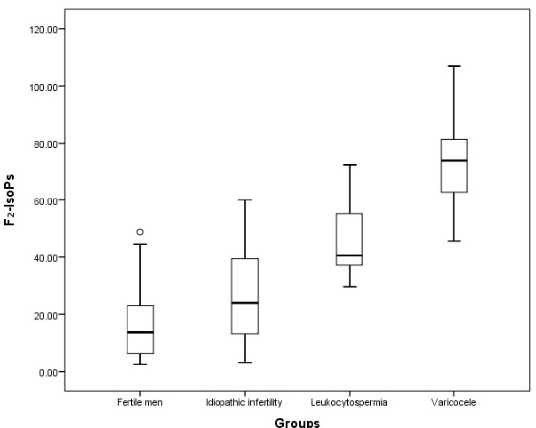
Figure 3. F 2 -IsoP levels in the four examined groups. Values are expressed as median and interquartile ranges (IQR). The symbol on top is an outlier. The seminal RvD1 levels were significantly increased in patients with leukocytosper- mia (respectively, p < 0.01 and p < 0.001) and varicocele (both p < 0.001) compared to those measured in the idiopathic infertility group and fertile men (Figure 4).